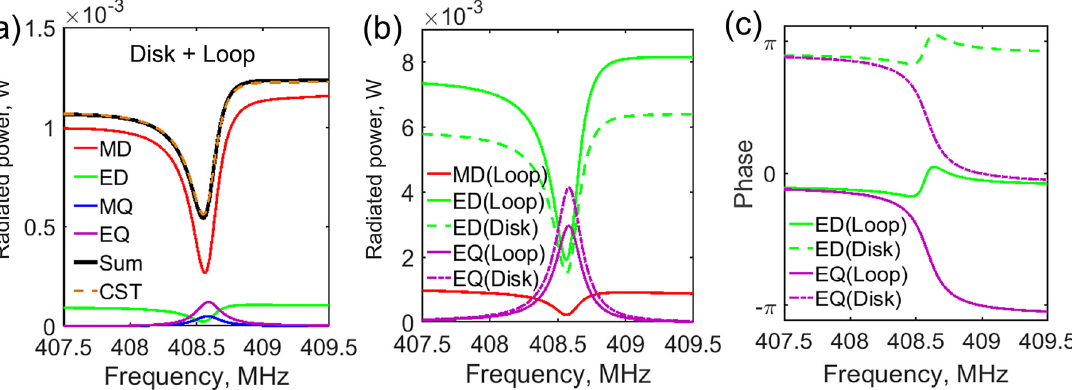
Figure 3: Cartesian multipole decomposition of radiated power of (a) the NR source (disk + loop); (b) the single dielectric disk and loop of the NR source; (c) phase of the ED and EQ radiations from the loop and